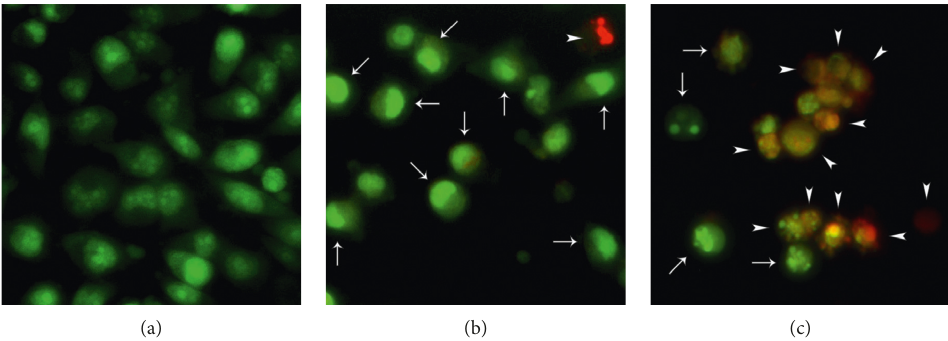
Figure 2: Fluorescent micrographs of acridine orange and ethidium bromide stained HeLa cells, untreated (a) or treated with [Ph 3 Sn(CEMPD)] for 24h (b) 2 IC 50 and (c) 4 IC 50 . Arrows indicate apoptotic cells with condensed chromatin and/or fragmented nuclei × × while arrowheads mark necrotic cells.